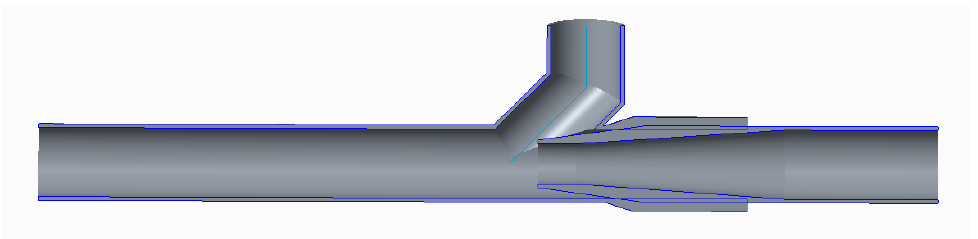
Figure 3. Structure diagram of jet feeder.